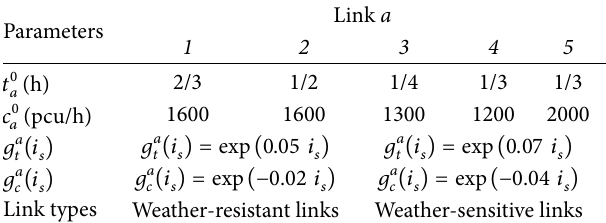
Table 4: Network configuration inputs.